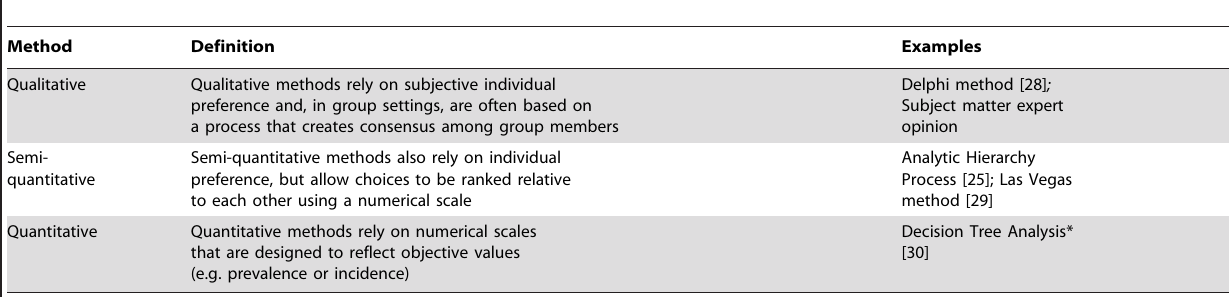
Table 1. Methods used for criteria selection, weighting and scoring of